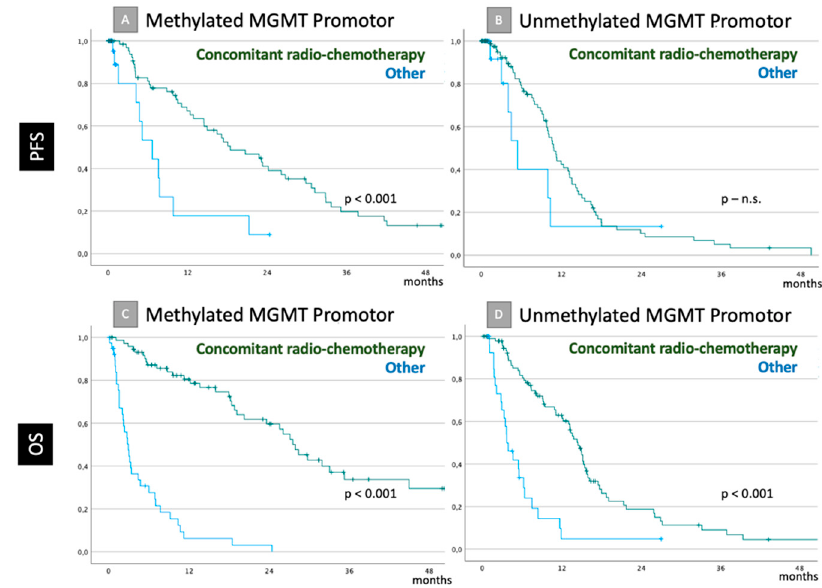
Figure 1. PFS ( A & B ) and OS ( C & D ) in the entire cohort considering MGMT promotor status if Figure 1. PFS ( A , B ) and OS ( C , D ) in the entire cohort considering MGMT promotor status if concomi- concomitant radio-chemotherapy was initiated or not is shown as Kaplan–Meier curves. tant radio-chemotherapy was initiated or not is shown as Kaplan–Meier curves. Significance level is provided in conformity to LogRank tests. Statistically significant differences were revealed in all cases ( A , C , D ), except for PFS changes in case of an unmethylated MGMT promotor ( B